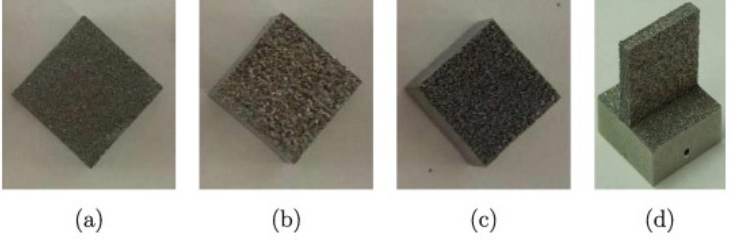
Figure 10. Aluminum alloy samples manufactured using DMLS with different average surface roughness: 16 µm ( a ), 24 µm ( b ), 43 µm ( c ), 22 µm ( d ) [72].